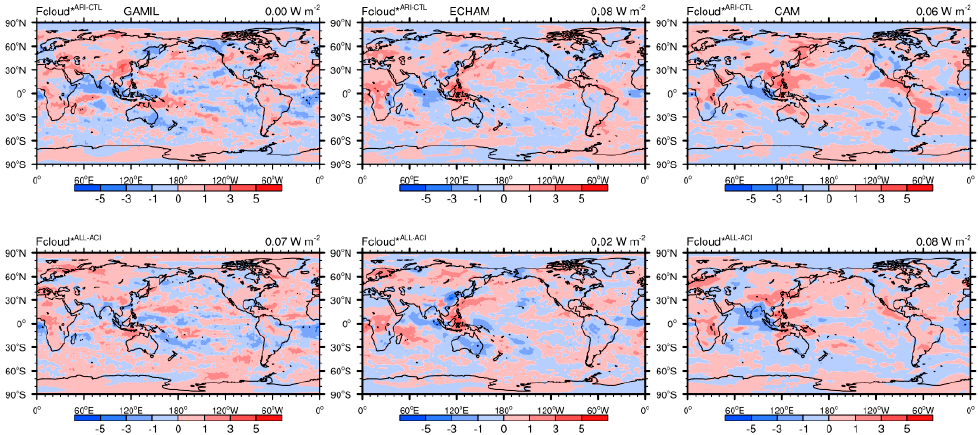
Figure 5. Anthropogenic aerosol effects on shortwave cloud forcing from aerosol–radiation interactions with the GAMIL (left), ECHAM (middle), and CAM (right) models. The upper panel (Fcloud *ARI − CTL ) shows the differences in shortwave cloud forcing between the ARI and CTL experiments. The lower panel (Fcloud *ALL − ACI ) shows the differences between the ALL and ACI experiments. The number on the top right of the figure denotes the ensemble average of global annual mean values. Differences significant at the 10% level of the Student’s t -test are depicted by dots.